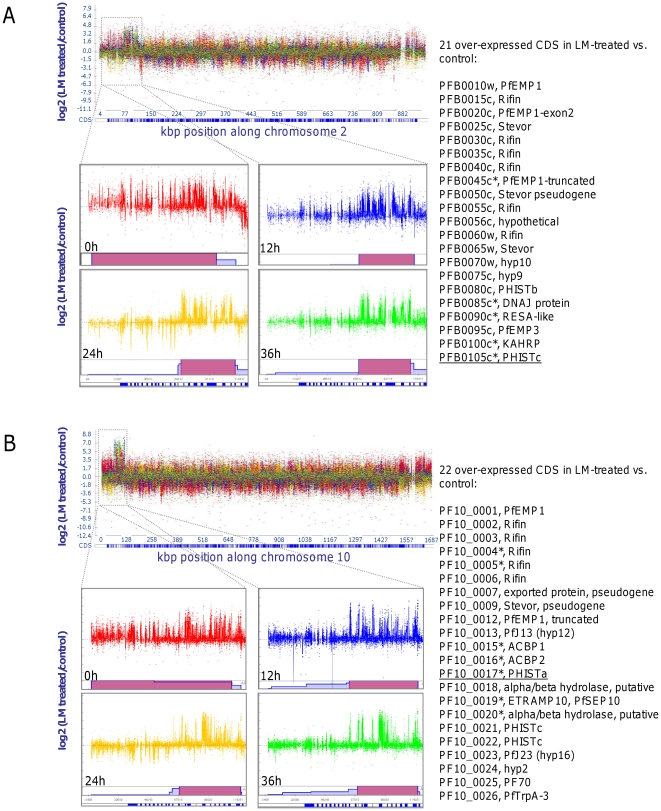
Chromosomes 2 (A) and 10 (B) show over-expression of contiguous probes covering 21 and 22 CDS, respectively.Amplification of the signals for the left arms of chromosomes 2 (A) and 10 (B) are enlarged for each time point as indicated. Every single coloured dot corresponds to a 25-mer probe: red is for 0 h, blue for 12 h, green for 24 h and yellow for 36 h. Underneath every enlarged chromosomal arm are pink bars indicating 100% robustness of signal amplification at p<0.01 (using SnoopCGH program with Smith–Waterman algorithm implementation). A normal distribution of the log ratios (y-axis) around the zero horizontal line is expected if the expression levels are the same along the chromosome (indicated as kilo base pair [kbp]). The CDS (represented under each chromosome by blue rectangles) contained within each amplified region are indicated on the right with their appropriate annotation (www.genedb.org). The genes marked with an * have been found significant at B>0 in the pairwise comparisons of the microarray data in at least one time point, while the underlined genes have been double checked by qRT-PCR.